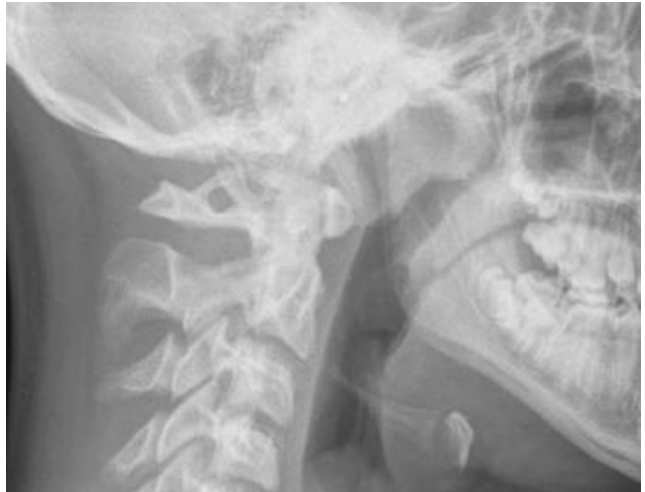
Figure 1. Ponticulus posticus (PP) full ring.